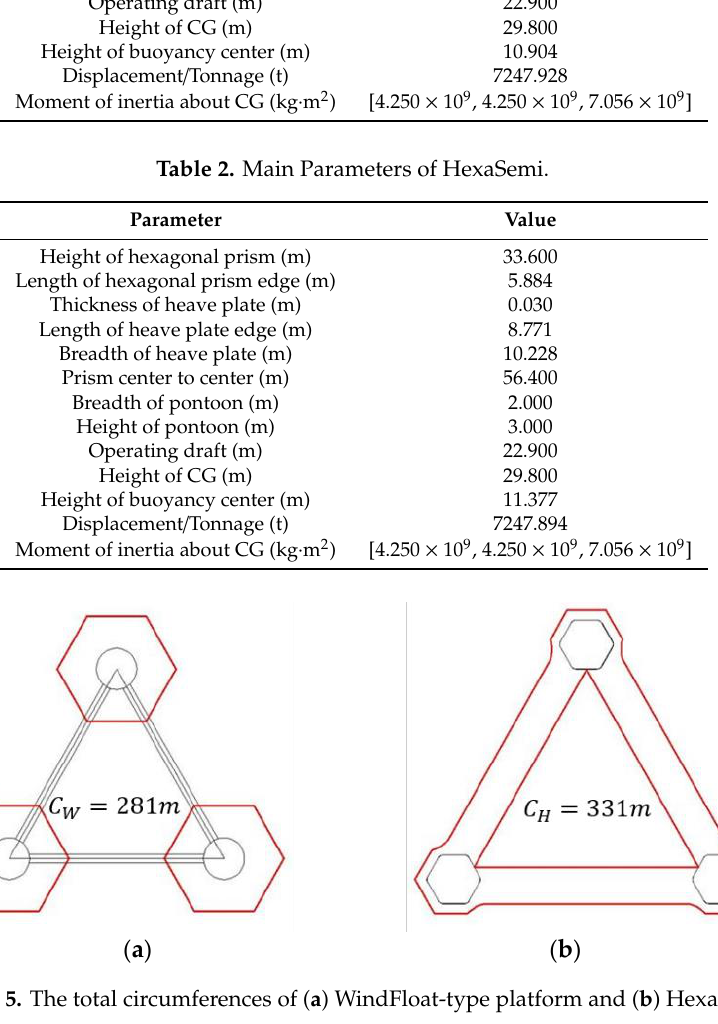
Table 2. Main Parameters of HexaSemi.